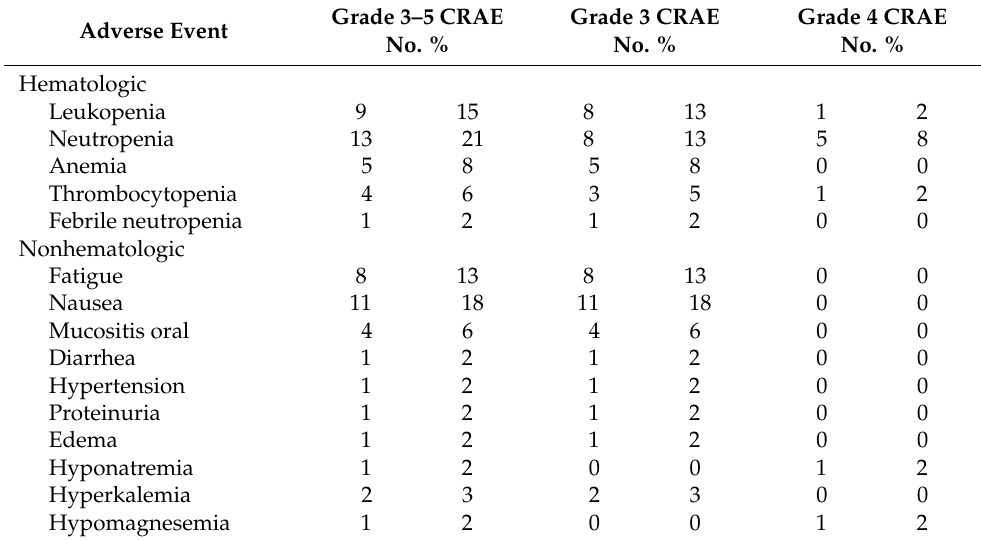
Table 3. Chemotherapy-related adverse events.